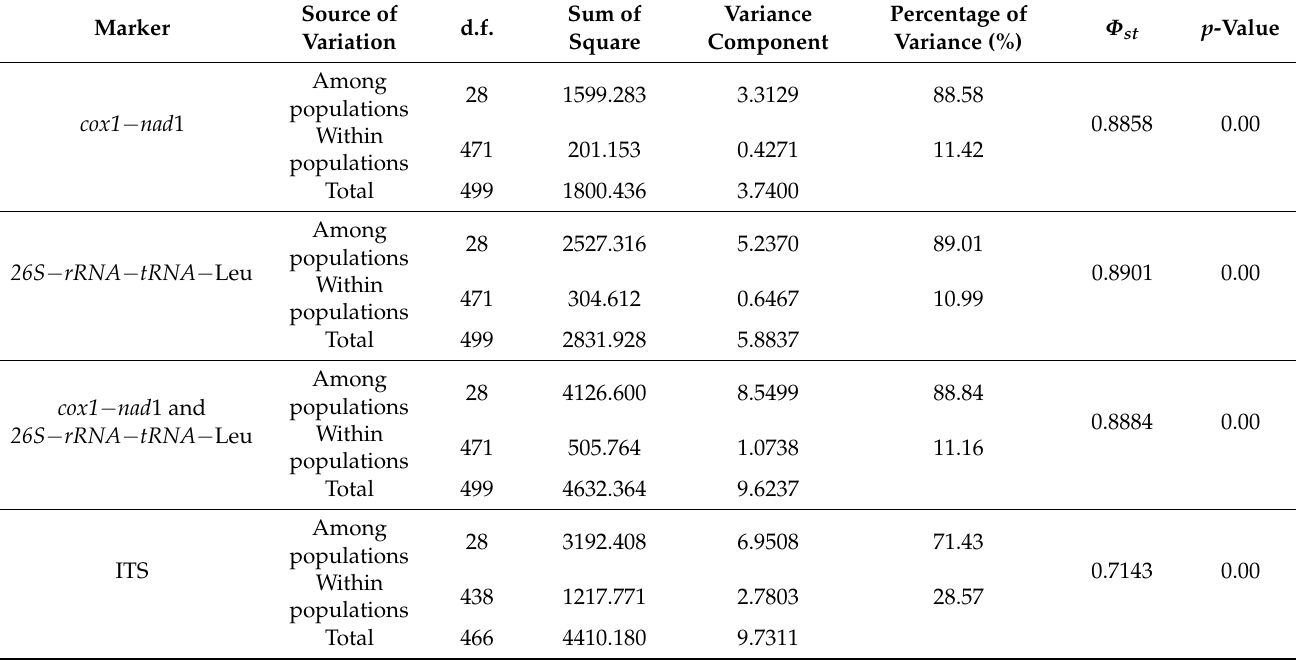
Table 3. Analysis of molecular variance (AMOVA) using mtDNA and nrDNA ITS sequences of T. ciliata